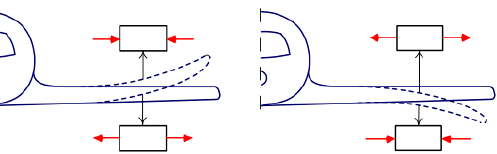
Figure 4. Deformations due to aerodynamic forces applied to an aircraft wing.